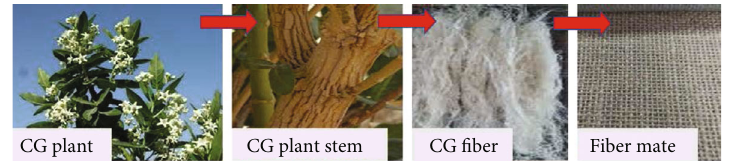
Figure 1: Extraction of Calotropis gigantea fi ber (CGF) from Calotropis gigantea plant.